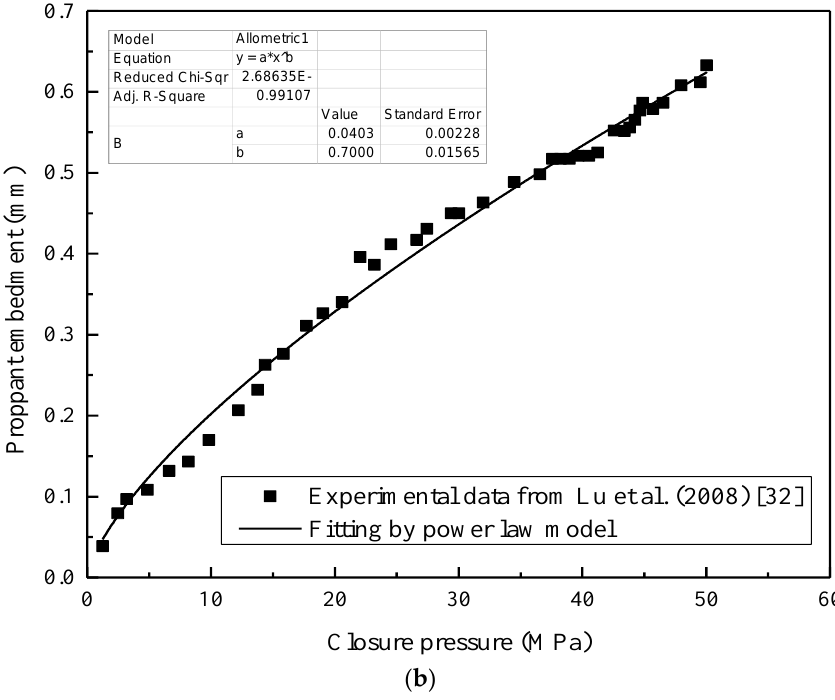
Figure 3. Fitting for proppant embedment by power law model. ( a ) Proppant embedment test 1 [31]; ( b ) Proppant embedment test 2 [32].